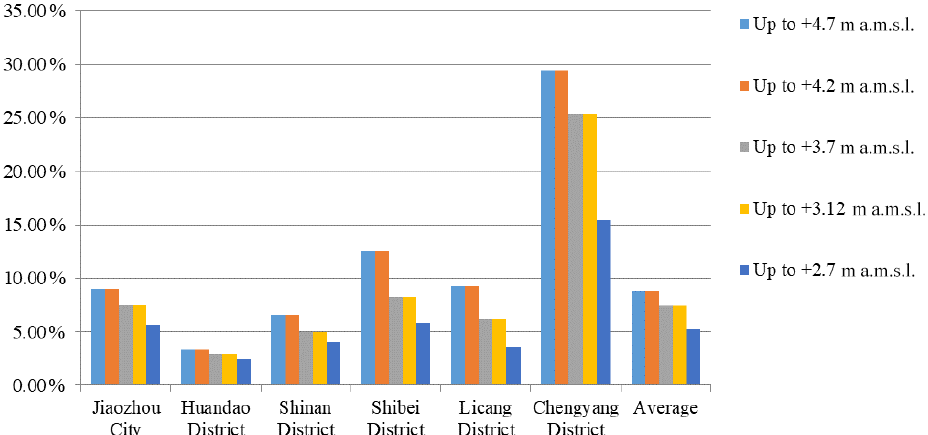
Figure 3. Histogram of the inundated percentage of Qingdao coastal zone generated on